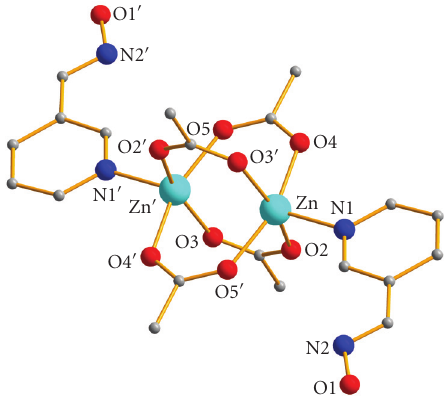
Figure 3: Partially labeled plot of the molecular structure of 2 · H atoms have been omitted for clarity.